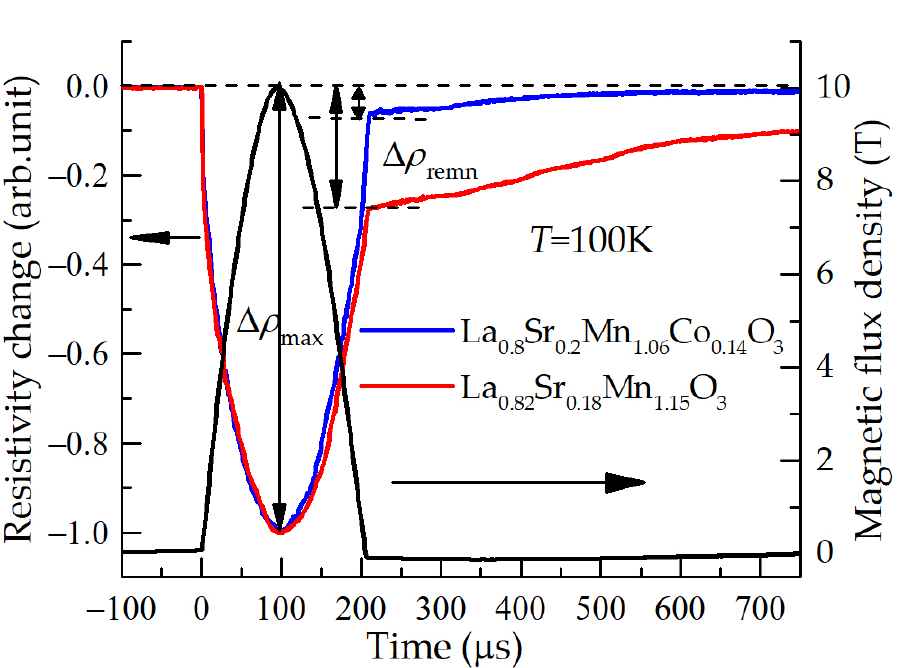
Figure 4. Magnetic field pulse (right scale) and resistivity change of the films with different chemical composition (left scale) during and after this pulse.